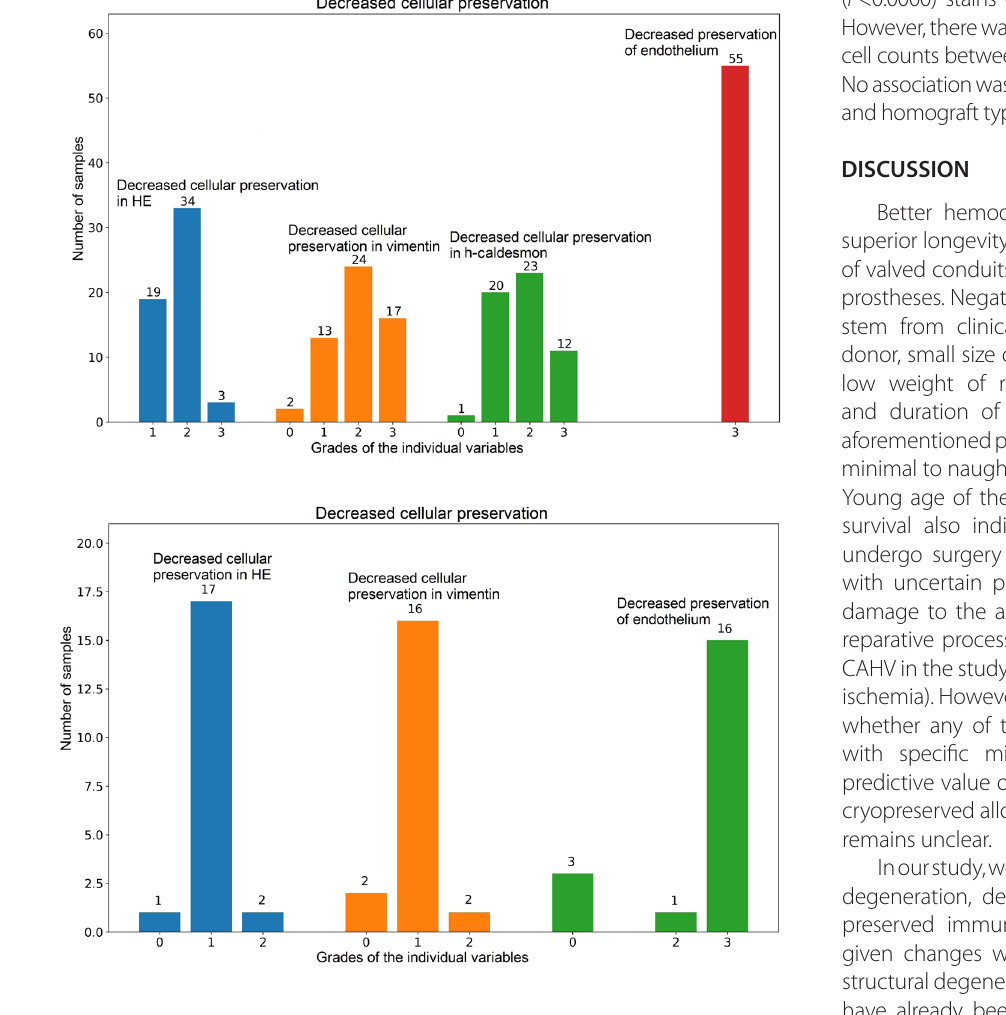
Fig. 2 - Bar plots showing individual components of decreased cellular viability in arterial (A) and valvar (B) samples (only the non-zero variables are shown). X-axis shows grades of severity for each individual variable, y-axis provides number of samples in each category (different colors of the bars were used only for a better understandability of the picture). HE=hematoxylin and